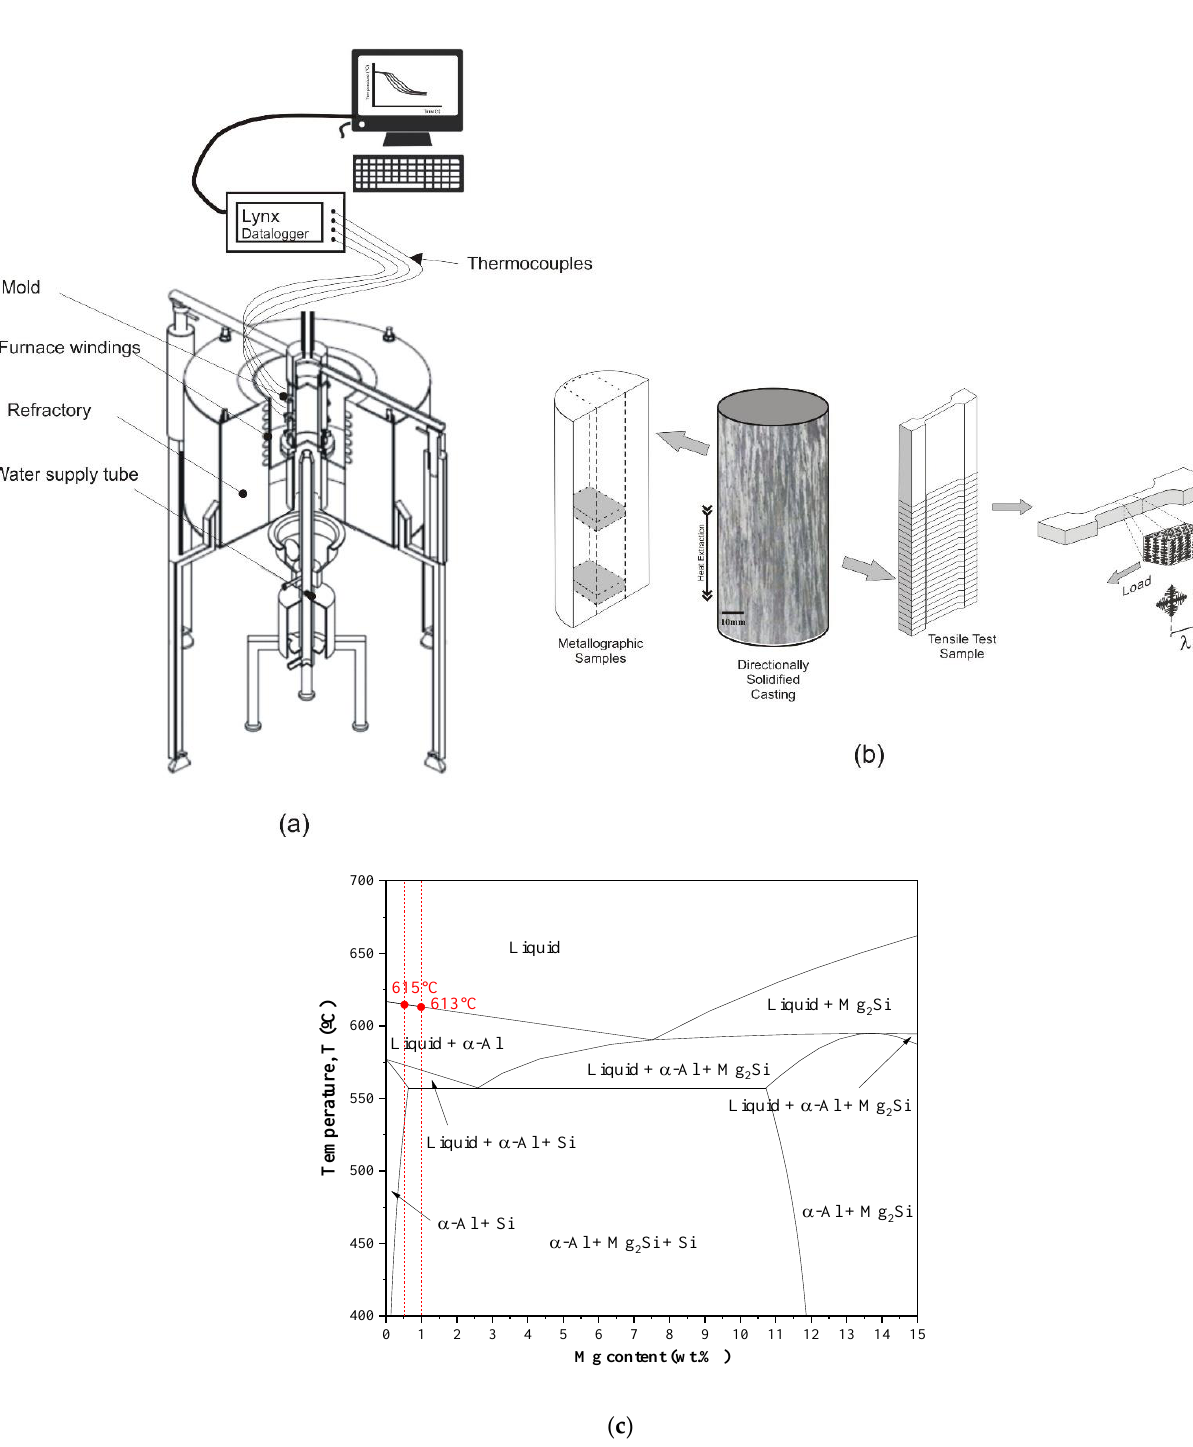
Figure 1. Schematic representations: ( a ) of the water-cooled upward directional solidification system and ( b ) of the procedures for the extraction of the samples for metallography and tensile tests along the length of the directionally solidified (DS) Al-7Si-xMg alloy castings; ( c ) Partial Al-7Si-xMg pseudo binary phase diagram calculated by the Thermo-Calc software (TTAL database), with vertical dashed lines indicating the nominal composition of each examined alloy.